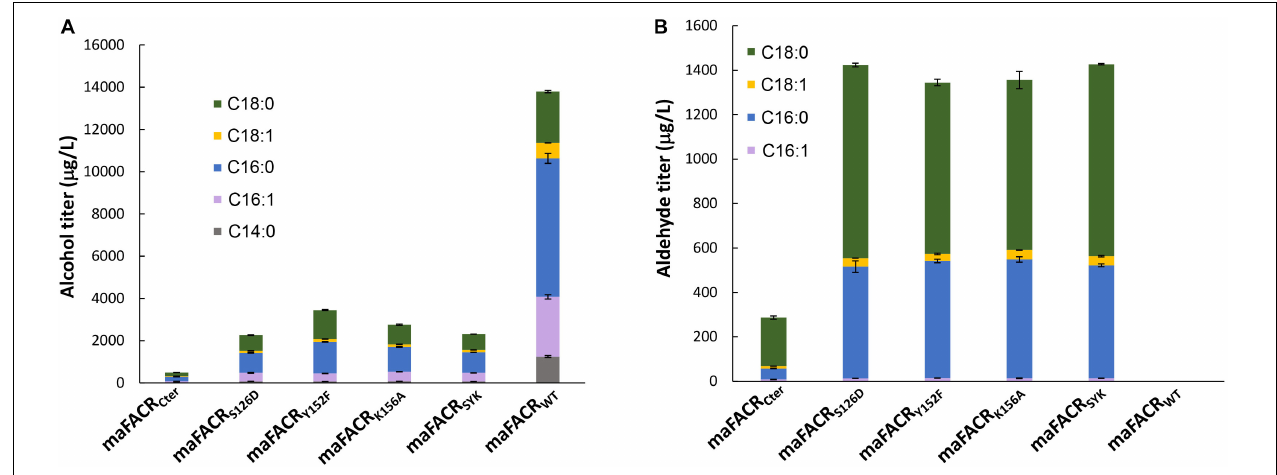
FIGURE 3 | Fatty aldehyde and alcohol production by maFACR variants in Saccharomyces cerevisiae . Fatty aldehyde and alcohol production titers from S. cerevisiae expressing variants of maFACR are shown in (A,B) , respectively. Wild-type maFACR did not produce detectable fatty aldehyde. Data are shown as the mean ± SD of biological